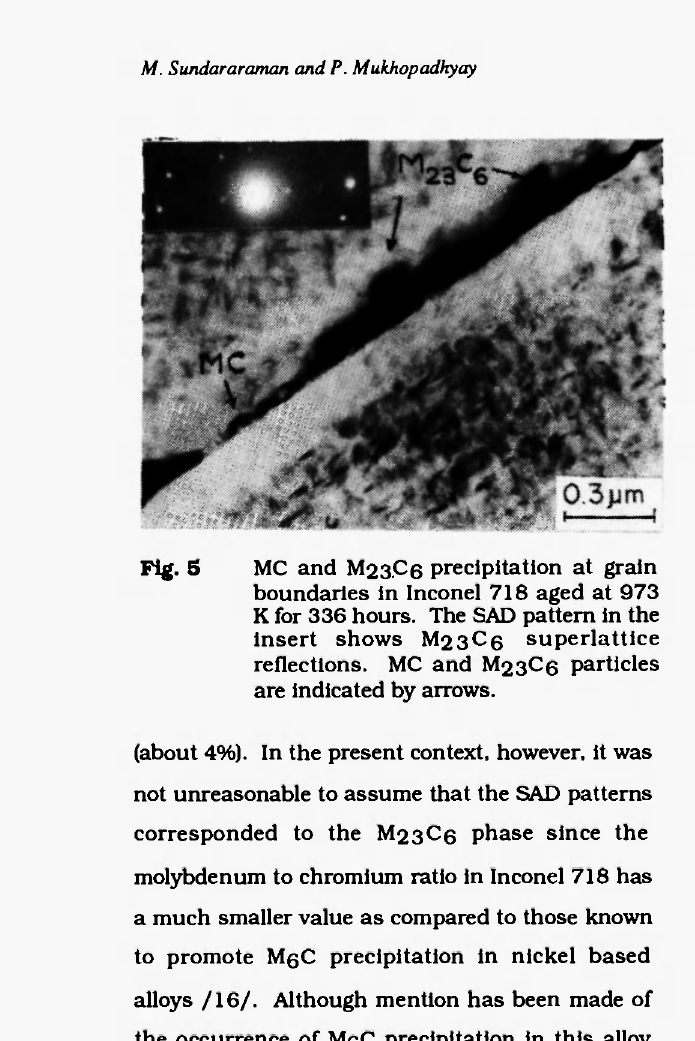
Fig. 5 MC and M23.Ce precipitation at grain boundaries in Inconel 718 aged at 973 Κ for 336 hours. The SAD pattern in the insert shows M23C6 superlattice reflections. MC and M23C6 particles are indicated by